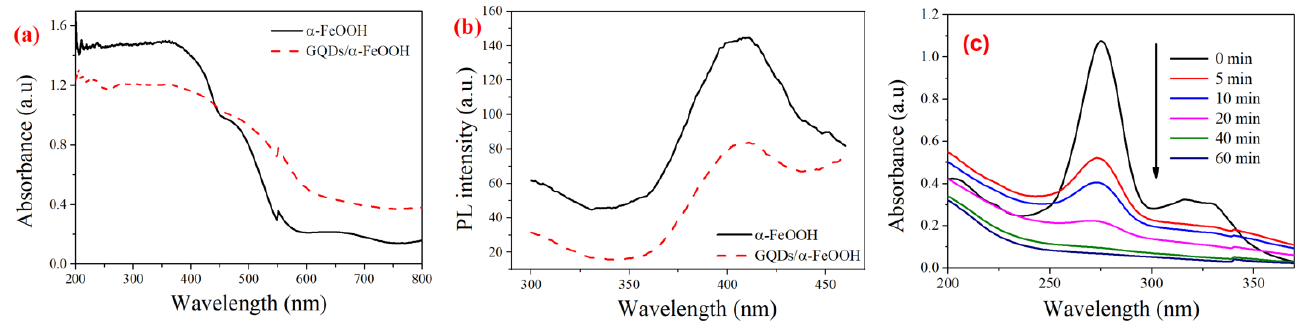
Figure 6. UV–Vis DR spectra ( a ) and PL spectra ( b ) of α -FeOOH and GQDs/ α -FeOOH and ( c ) temporal evolution of the UV–Vis spectra during the elimination of CIP in the GQDs/ α -FeOOH + H 2 O 2 + Vis system.